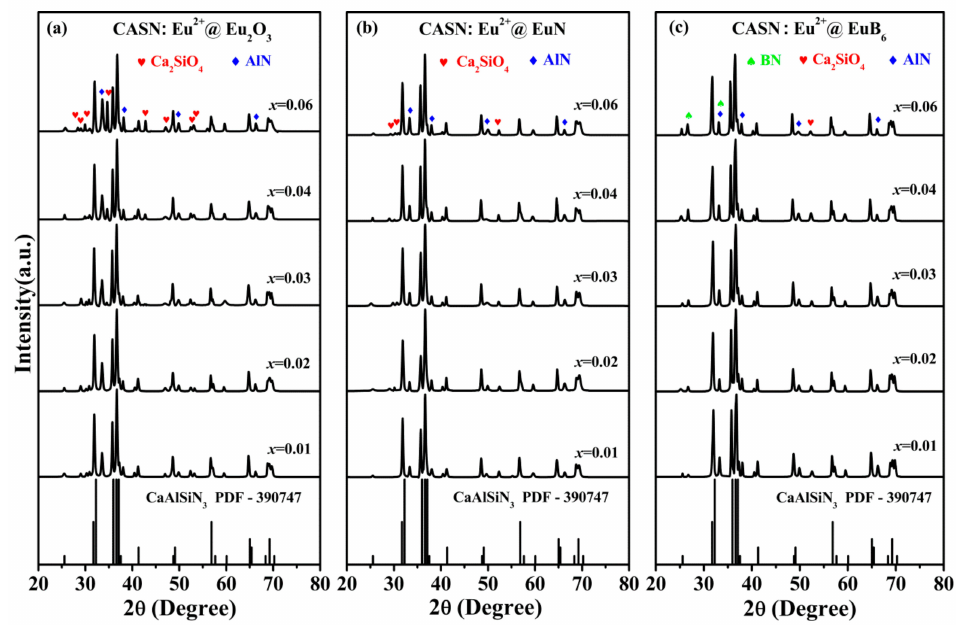
Figure 2. XRD patterns of three nitride red phosphors using different raw materials